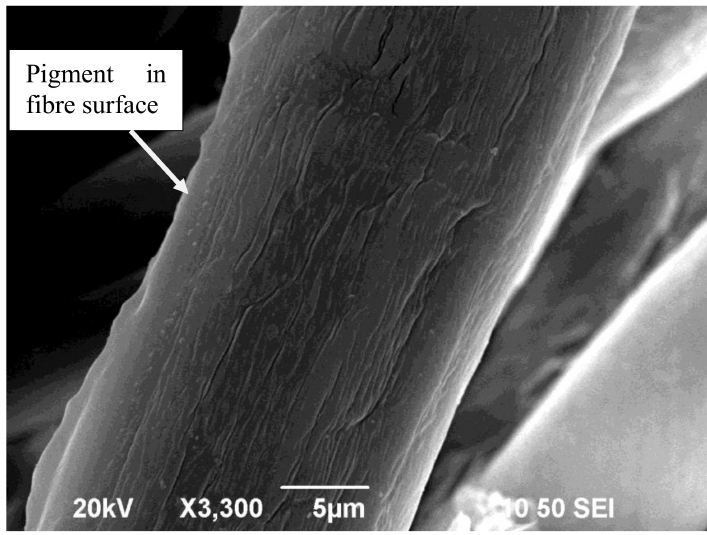
Figure 5. SEM image of atmospheric pressure plasma-treated cotton fibre after 5 g/L pigment dyeing (atmospheric pressure plasma treatment condition: discharge power = 170 W; oxygen flow rate = 0.6 L/min; head moving speed = 1 mm/s and head-to-substrate distance = 3 mm).